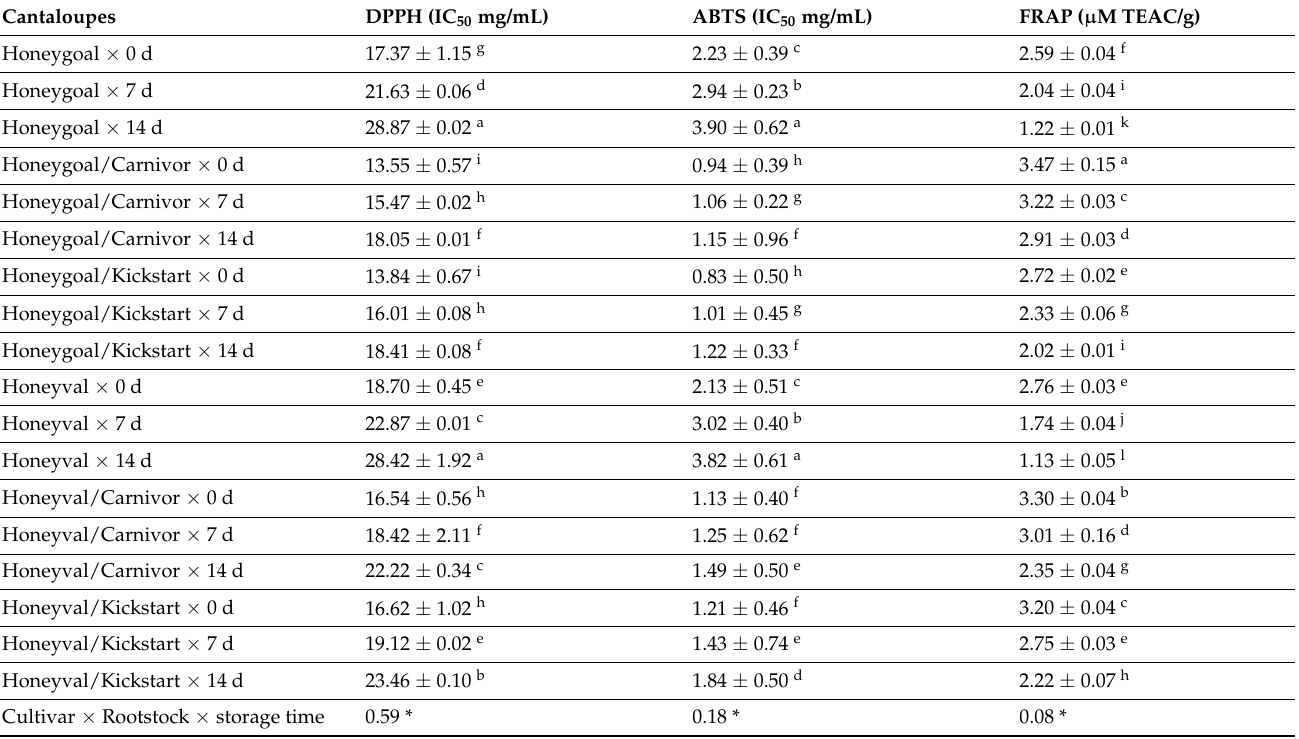
Table 2. Changes in antioxidant activities of grafted and un-grafted Honeydew melon cultivars during postharvest